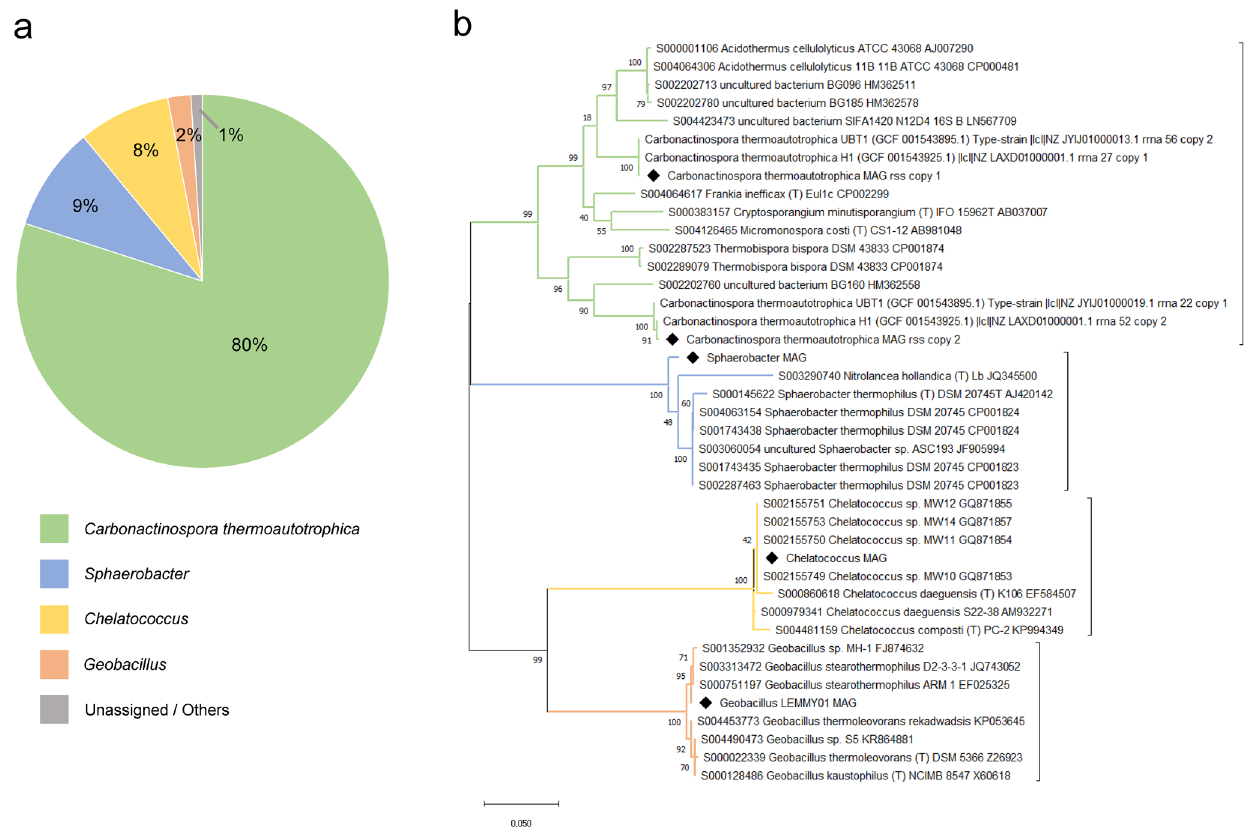
Fig. 3 Carbonitro fl ex metagenome composition. a Taxonomic composition and b molecular phylogenetic analysis of the carbonitro fl ex consortium based on the gene rrs (16 S); the maximum-likelihood method and Tamura – Nei distance model 57 were used to infer the evolutionary history. The tree with the maximum log probability is shown. The percentage of bootstrap trees in which the associated taxa clustered in this manner is shown adjacent to the branches. The rrs copies fi ltered from MAGs are highlighted with a diamond shape. The initial trees for the heuristic search were automatically obtained by applying the neighbor-joining and BioNJ algorithms to a matrix of estimated pairwise distances, using the maximum composite likelihood approach, and selecting the topology with the maximum logarithmic likelihood value. The tree is drawn to scale, with branch lengths proportional to the Tamura – Nei distance. The analysis included 32 nucleotide sequences. All positions containing gaps and missing data were eliminated. Evolutionary analyses were performed using MEGA7 56 . Table 1 CheckM output table showing the estimated contamination and completeness from the recovered MAGs and the Geobacillus LEMMY01 isolate.